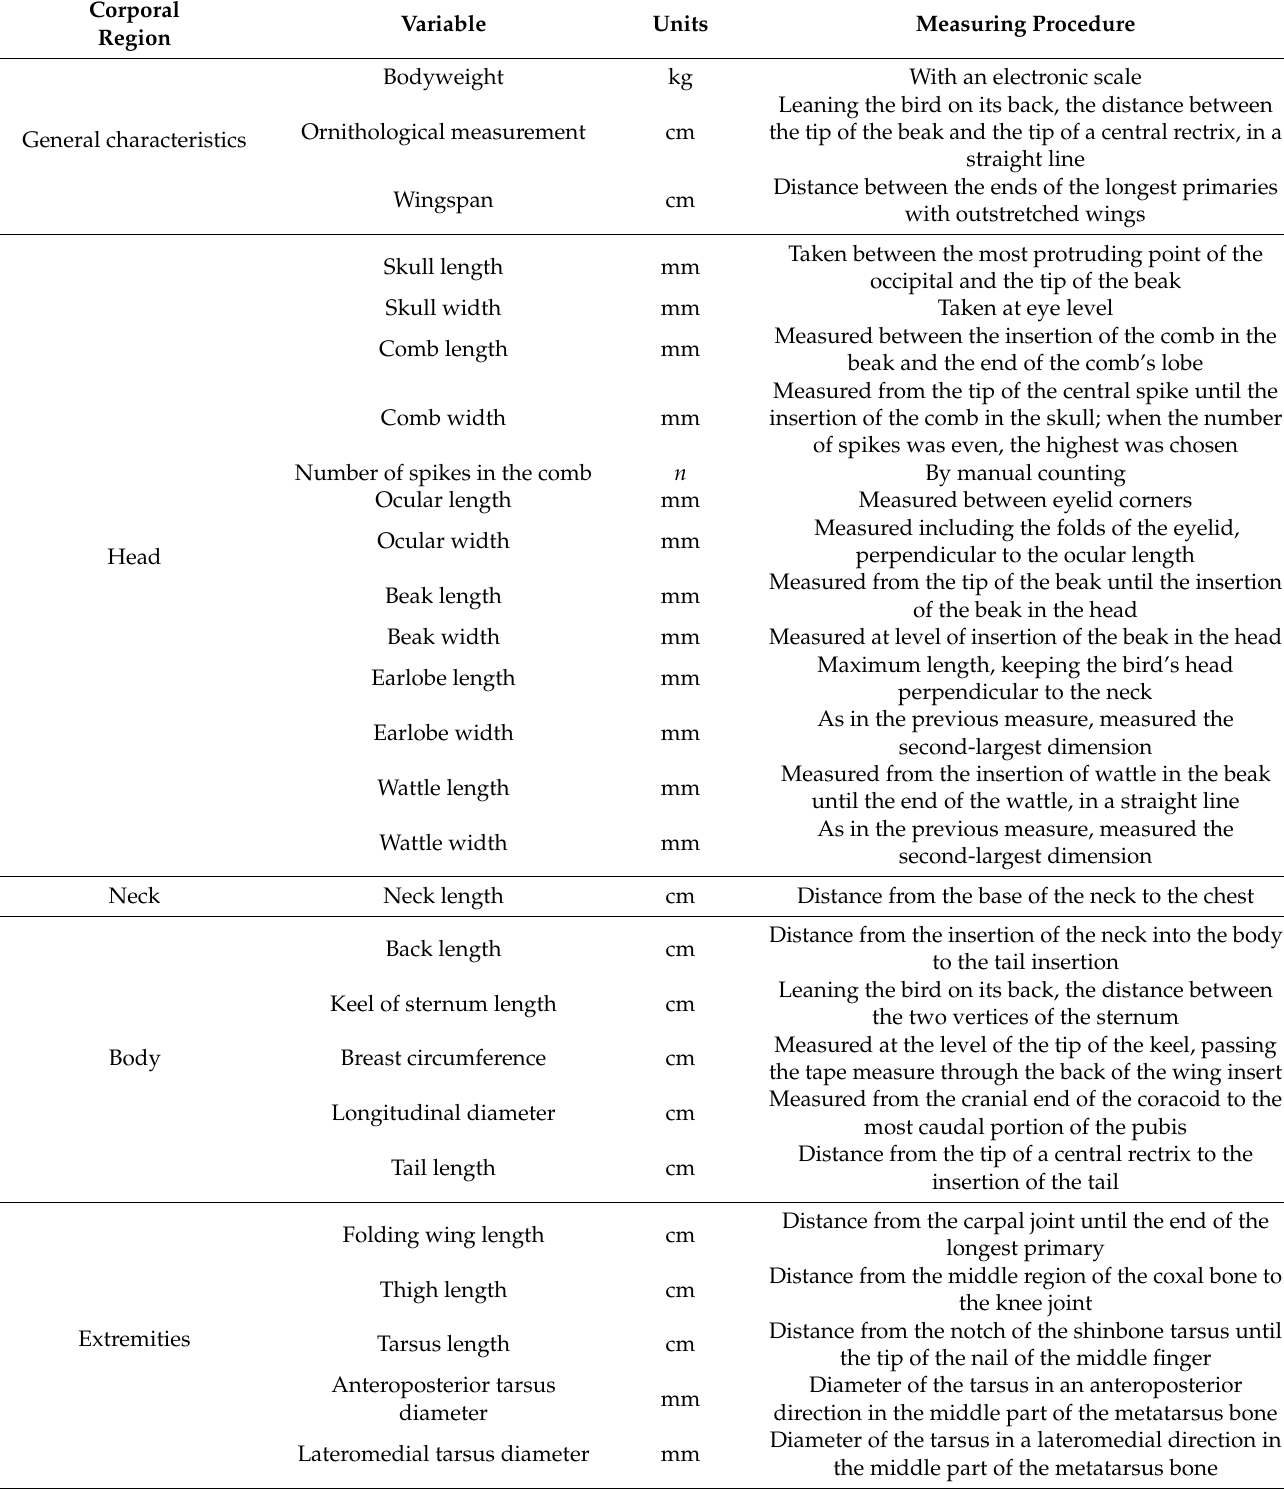
Table 1. Biometric variables and measuring procedures used in the present